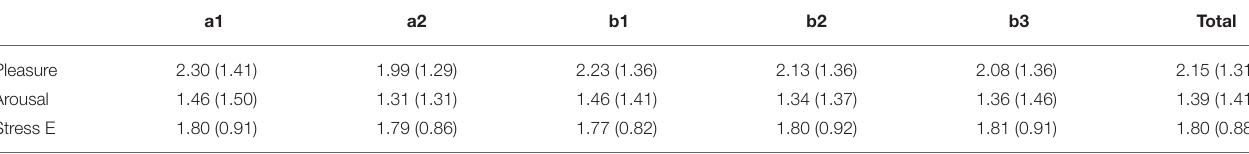
TABLE 6 | The elderly mean (SD) report in levels a and b.